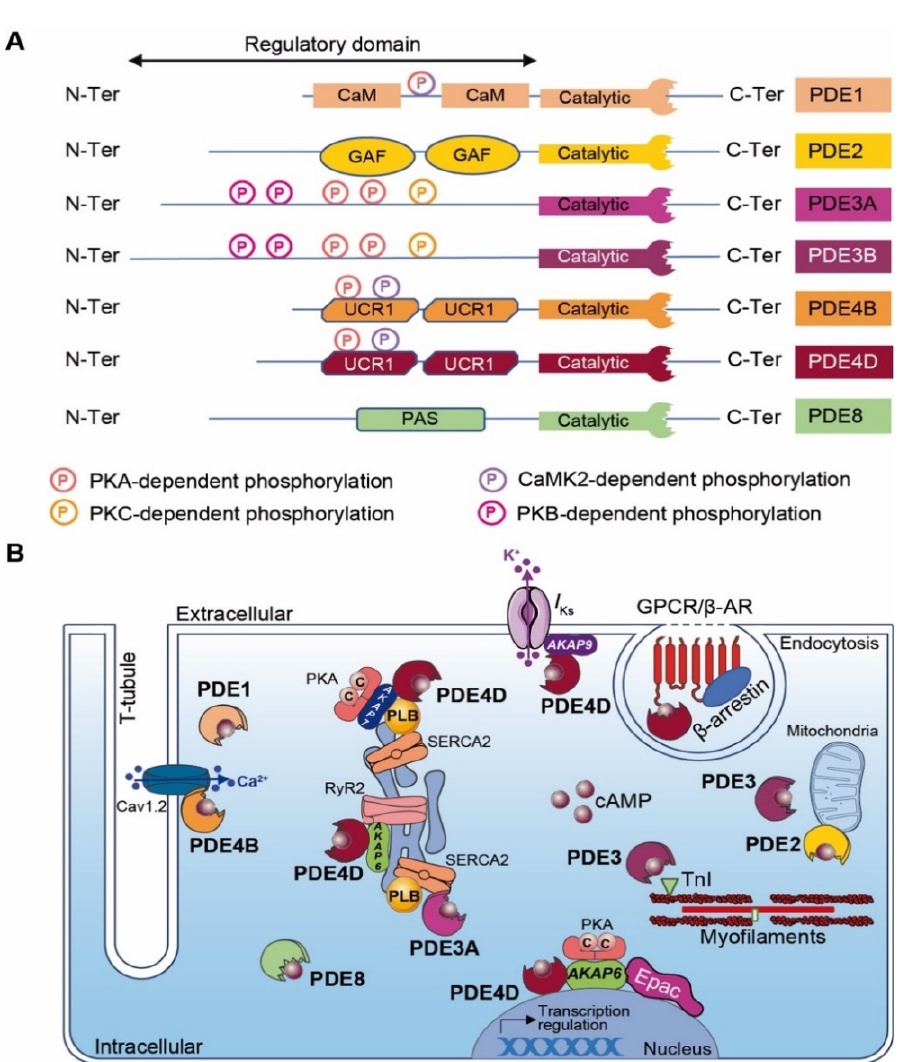
Figure 3. Cardiac cAMP-PDEs. ( A ) Structure of major cardiac cAMP-PDEs. PDEs exhibit a conserved C-terminal catalytic domain and a variable N-terminal regulatory domain. Kinase-dependent phosphorylation sites are indicated as circled P (light pink for PKA, yellow for PKC, purple for CaMK2, dark pink for PKB and mixed with light pink and purple for PKA and CaMK2). CaM: